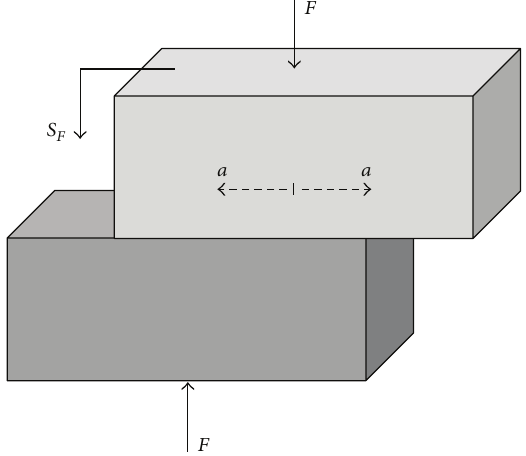
Figure 14: Selected process parameters in vibration welding.